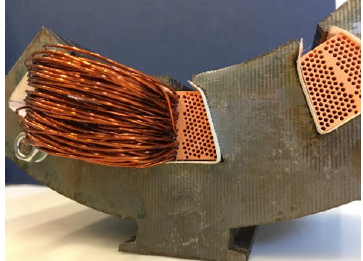
Figure 4. One wound coil in the experimental motorette with the slot former